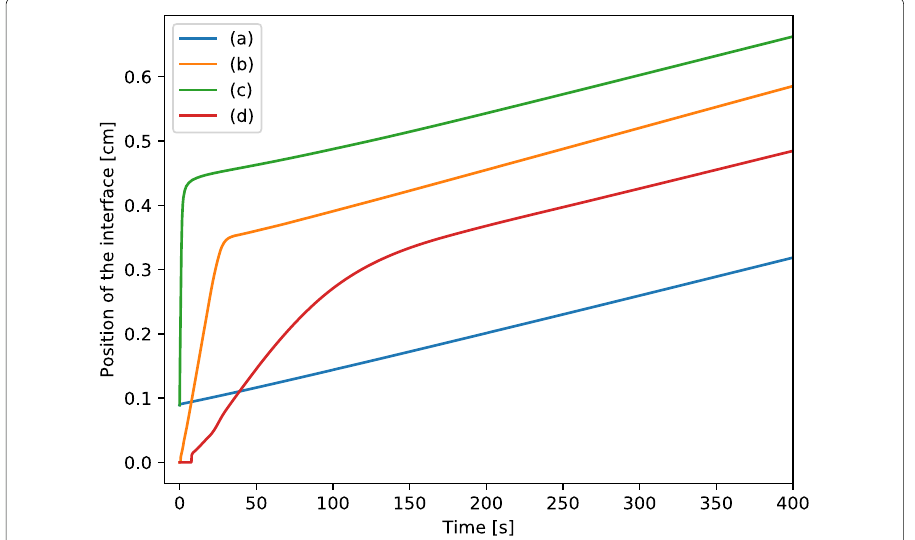
Fig. 18 Evolution of interface position with time for case (a), (b), (c), (d); for lettering see Fig.